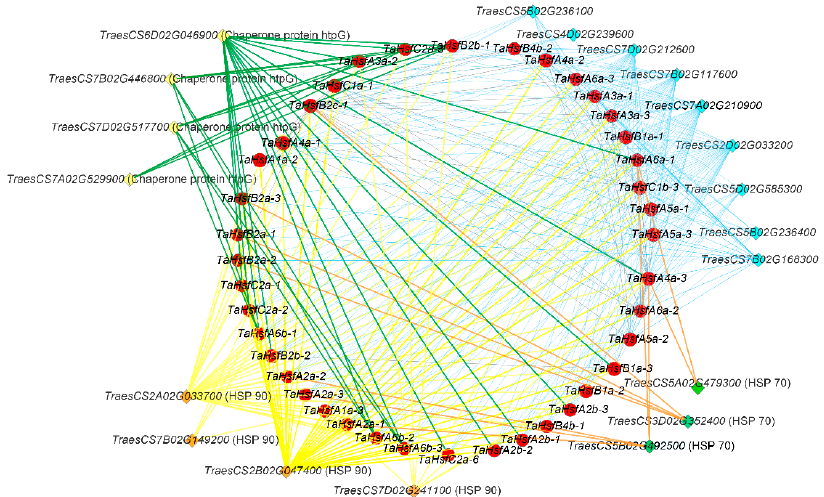
Figure 6. Interaction network between TaHsfs and related genes. The red circles represent TaHsfs and the diamonds in other colors represent the genes that interact with them. Lines connecting two genes show that an interaction exists between them.